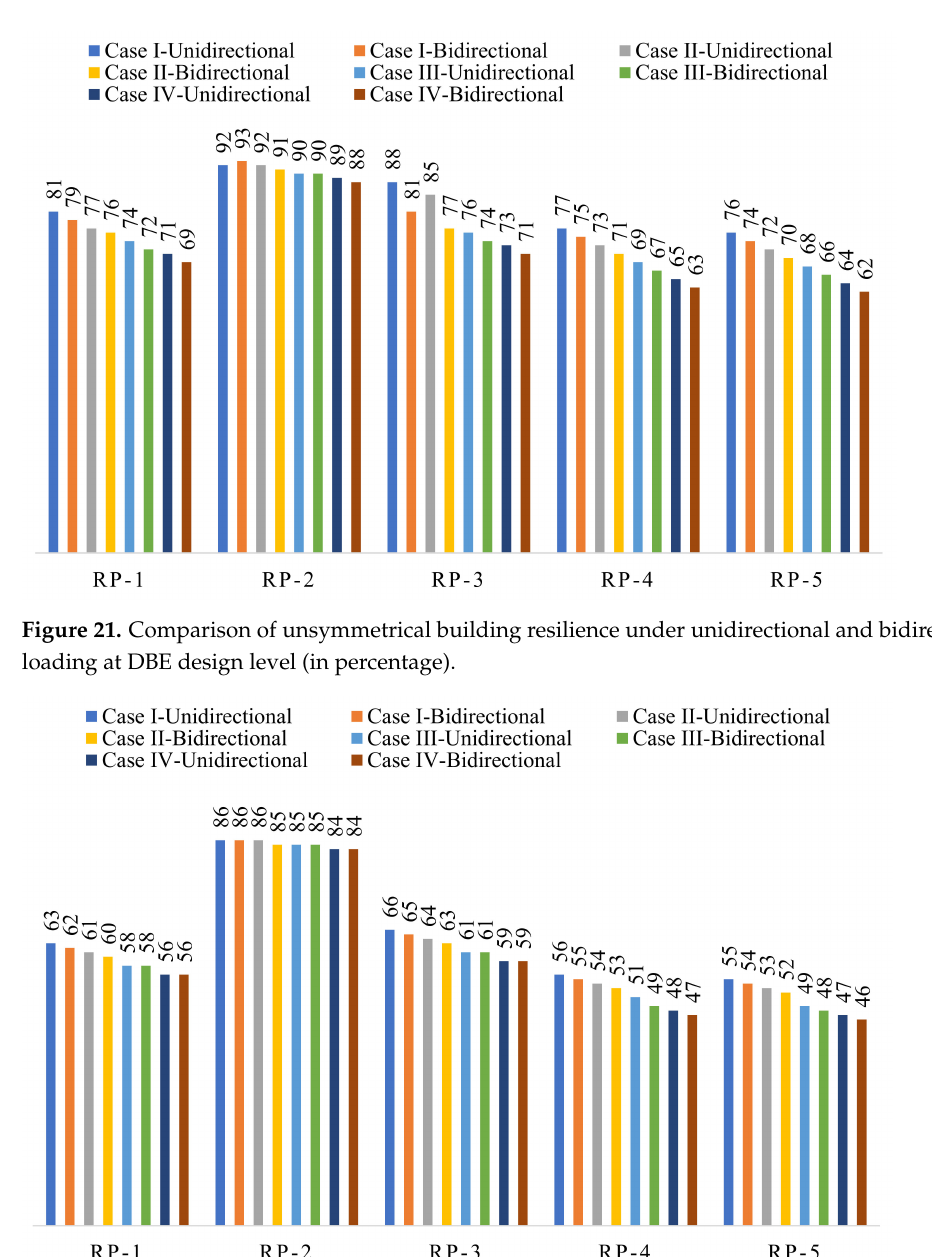
Figure 22. Comparison of unsymmetrical building resilience under unidirectional and bidirectional loading at MCE design level (in